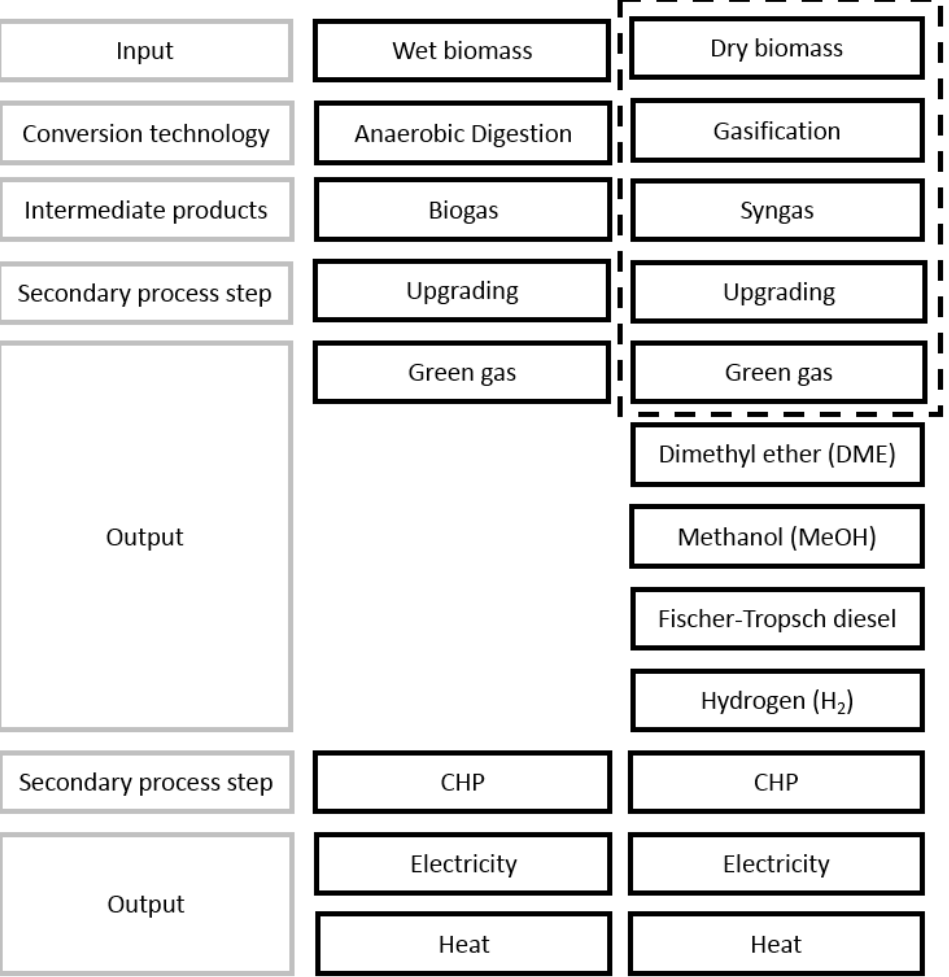
Figure 2. Overview of the possible green gas production routes from anaerobic digestion (AD) and gasification, including alternative output fuels.